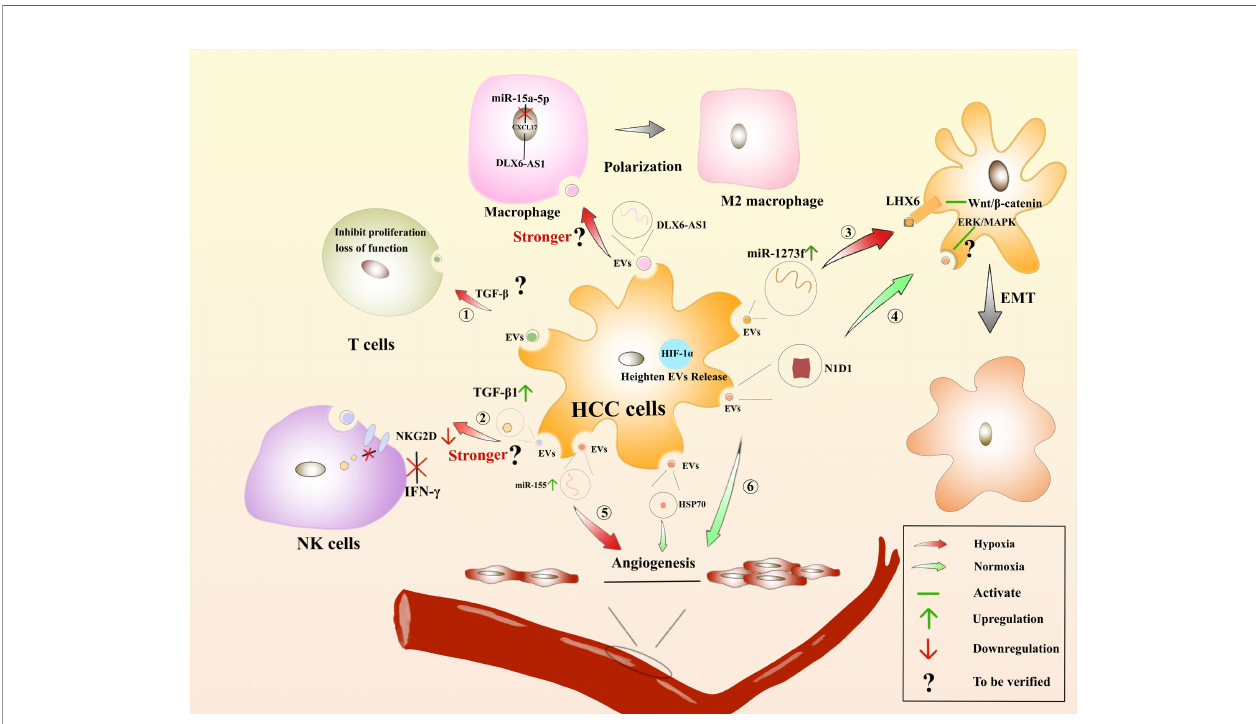
FIGURE 5 | Hypoxia-induced microenvironment affects the regulation of HCC by EVs : The role of EVs derived from HCC on immune cells in the hypoxic environment. ① Suppressing the proliferation of T cells or rendering them incompetent. ② Whether the inhibitory effect on IFN- b production by NK cells and the process of inducing macrophage polarization are enhanced remains to be veri fi ed. The role of HCC-derived EVs facilitates EMT. ③ In the hypoxic environments, miR-1273f is upregulated in HCC-derived EVs, acting on LHX6 to activate Wnt/ b -catenin to promote EMT. ④ In the normoxic environment, HCC-derived EVs contain N1D1, which may activate the ERK/MAPK pathway in recipient HCC cells to promote EMT. Regulation of angiogenesis by HCC-derived EVs. ⑤ In the hypoxic environments, miR-155 is upregulated in HCC-derived EVs and promotes angiogenesis. ⑥ In the normoxic environment, HCC-derived EVs are enriched in N1D1 and HSP1, which promote